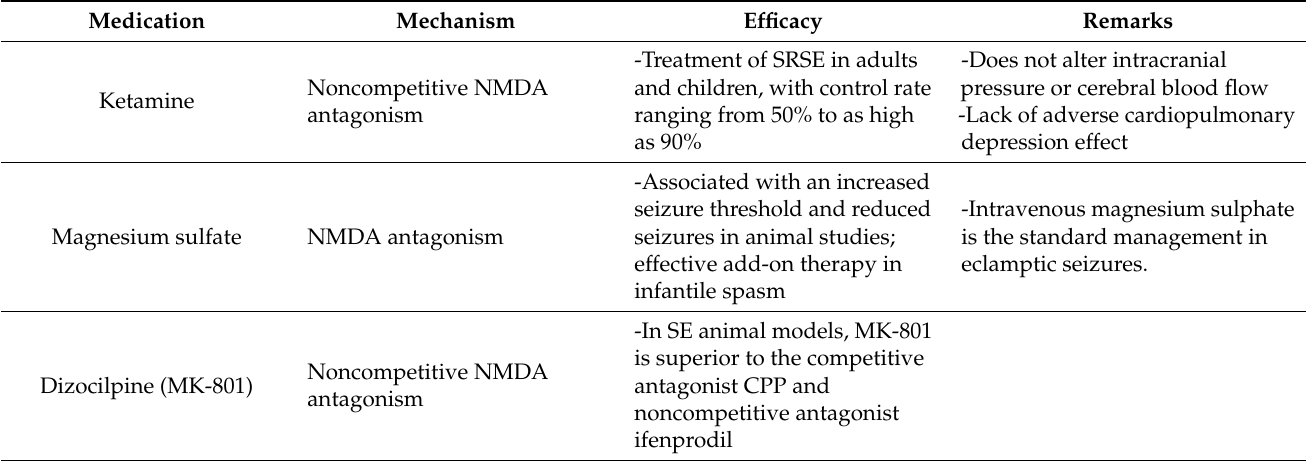
Table 1. Treatment of SE by various glutamate receptor (NMDAR)